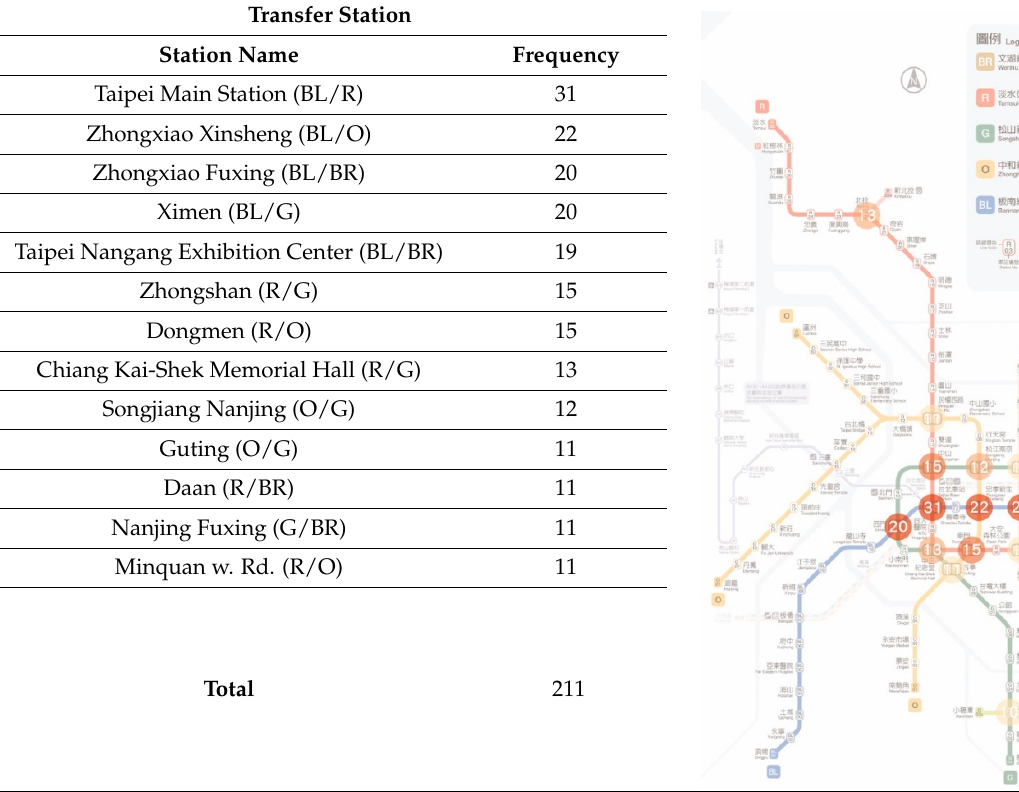
Table 4. Frequency and distribution of transfer stations as a drawing element.